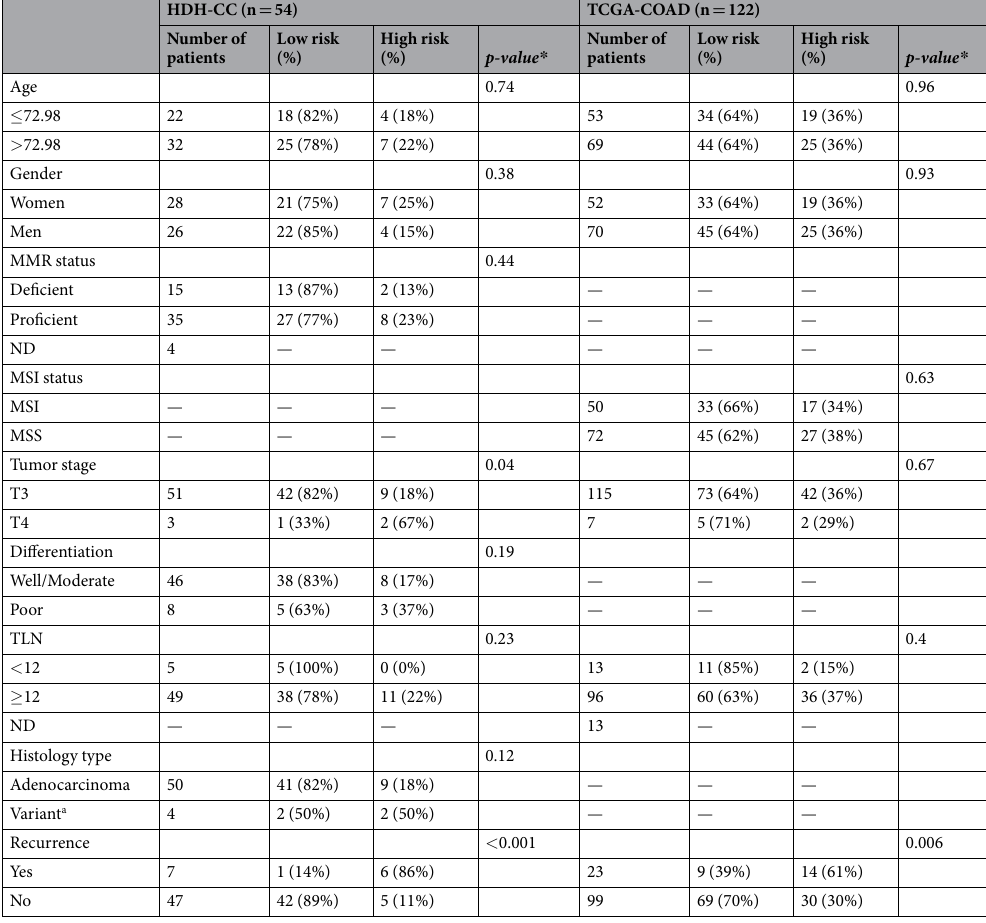
Table 1. Baseline characteristics of patients and their association with four-miRNA classifier. a Variant